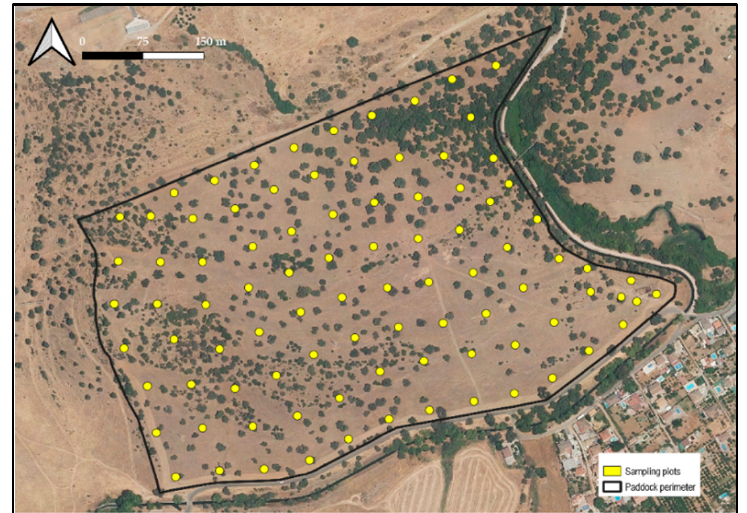
Figure 1. Distribution of dung sampling plots in the study paddock.